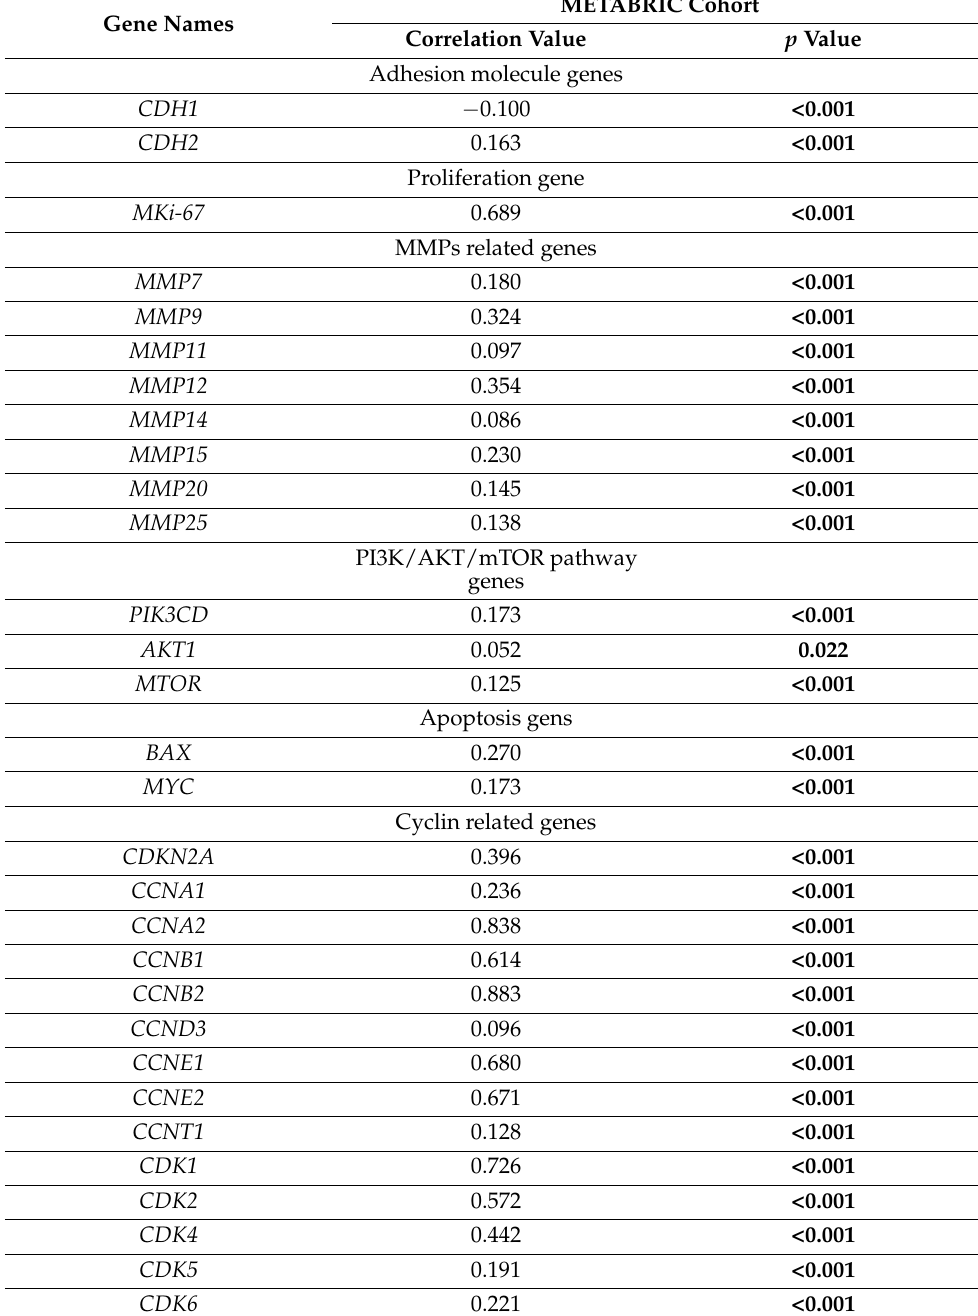
Table 2. Correlation of high CDCA5 mRNA expression with mRNA expression of adhesion molecule, MMPs, proliferation, PI3K/AKT/mTOR pathway, apoptosis, and cyclin related